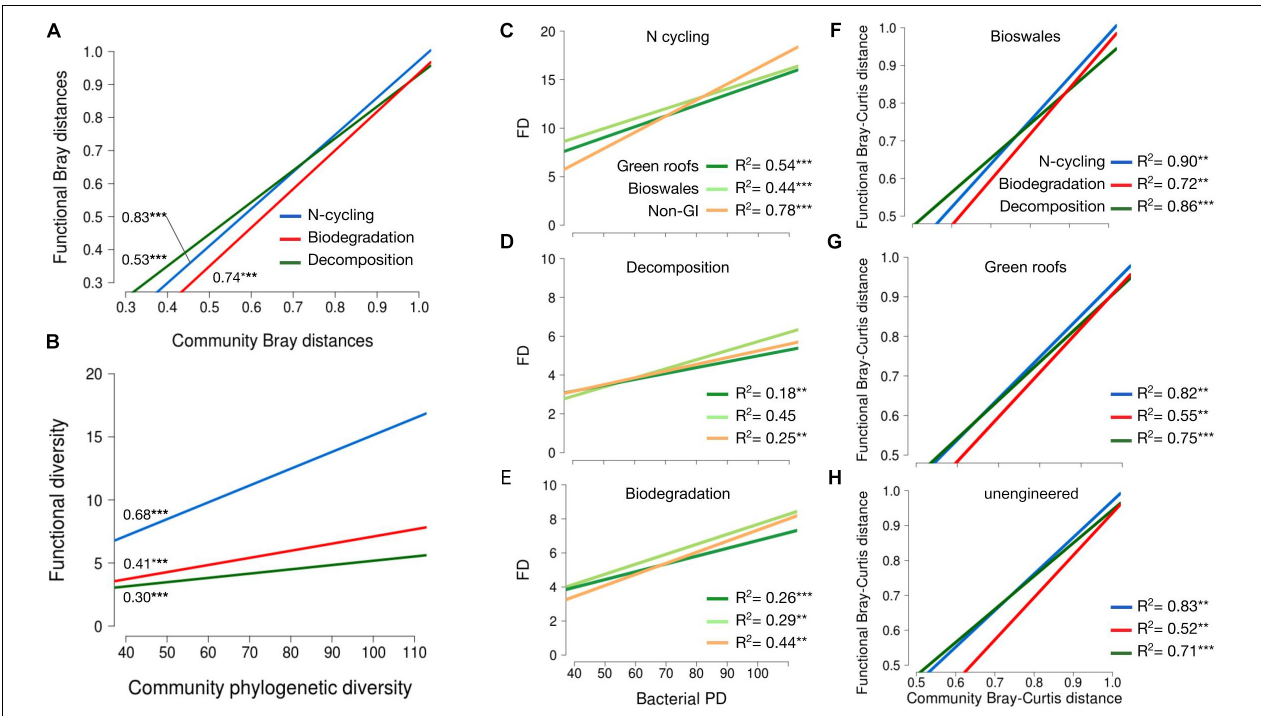
FIGURE 6 | (A) Linear regression of pairwise Bray–curtis distances for trait-associated variants against community pairwise Bray–Curtis distances. R 2 values shown denoted with significance as indicated. (B) Linear regression of functional diversity (phylogenetic diversity of trait-associated variants) against community phylogenetic diversity. R 2 values shown denoted with significance as indicated. (C–E) Functional versus phylogenetic diversity as in plot (B) , but broken down by habitat type for nitrogen cycling (C) , decomposition (D) and biodegradation (E) traits. Linear regression of pairwise beta-diversity differences for trait-associated variants versus community distances, shown separately for bioswales (F) , green roofs (G) , and non-engineered sites (H) . All data shown refer to bacterial communities. * p < 0.05, ** p < 0.01, *** p <